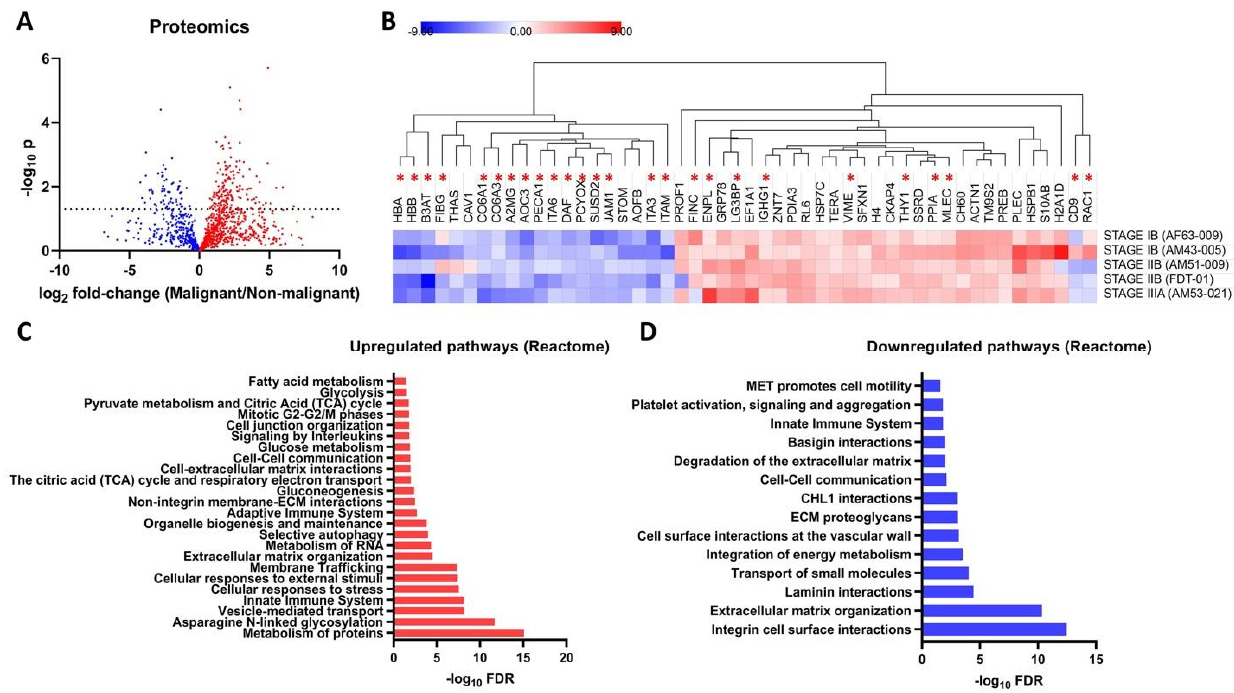
Figure 3. Cell surface proteome of tumor and peritumoral tissues from Filipino lung cancer patients. ( A ) Volcano plot showing differentially expressed proteins (222 significantly different proteins) between malignant (tumor)/non ‐ malignant (peritumoral) tissue. ( B ) Heatmap of selected highly ‐ significantly different proteins between tumor and peritumoral tissue. Values are expressed as log 2 fold ‐ change tumor/peritumoral tissue. The heatmap rows are labeled according to the patient source. Proteins with reported glycosylation sites are labeled with asterisks. Selected significant Upregulated ( C ) and downregulated ( D ) Reactome pathways (FDR = 5%) are annotated using PantherDB.